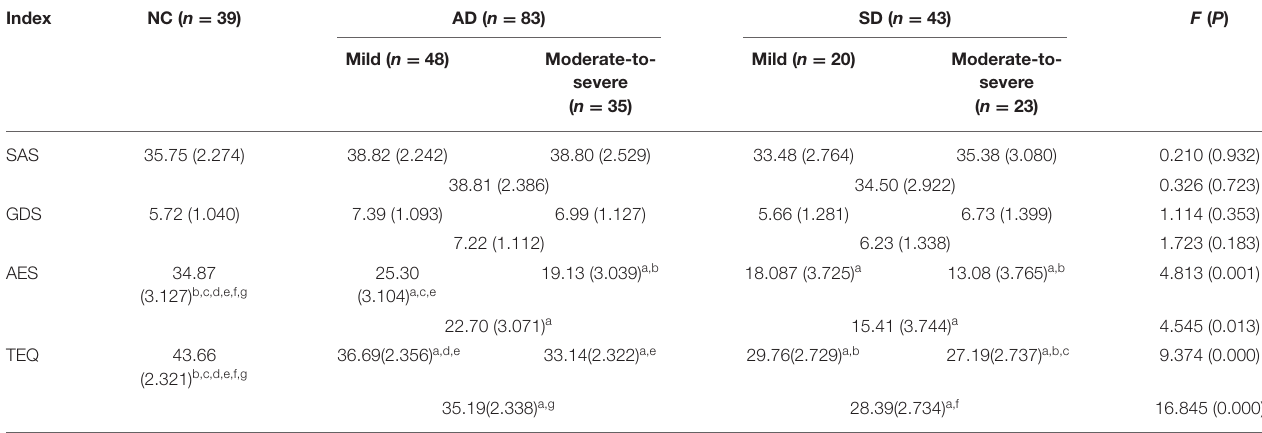
TABLE 3 | AS, GDS, AES, and TEQ performance of the groups.